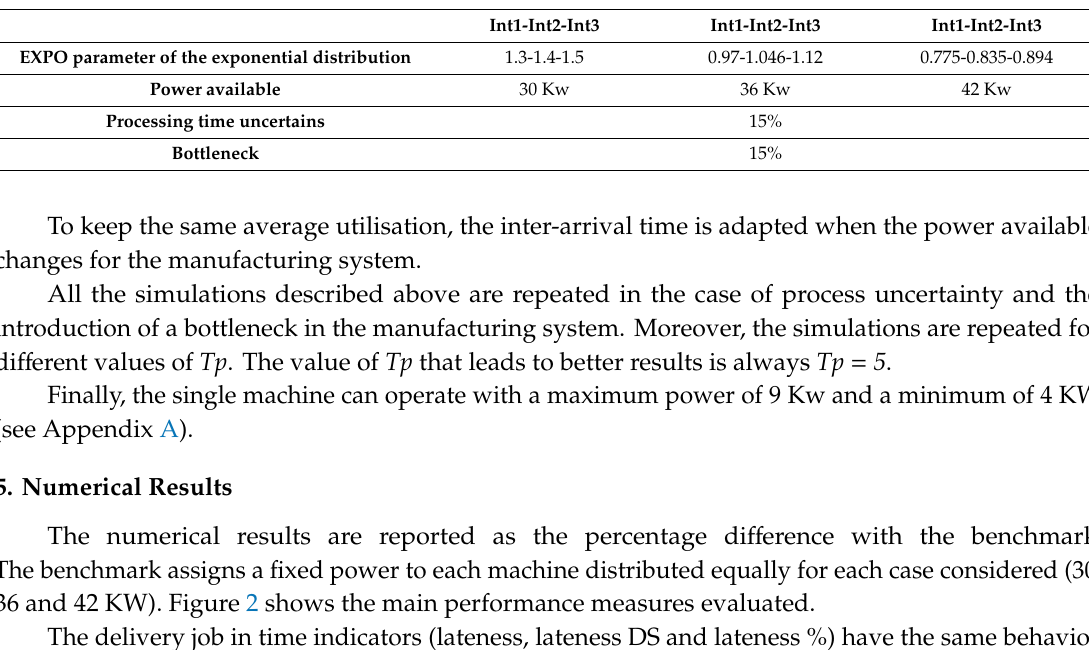
Table 1. Simulation parameters.